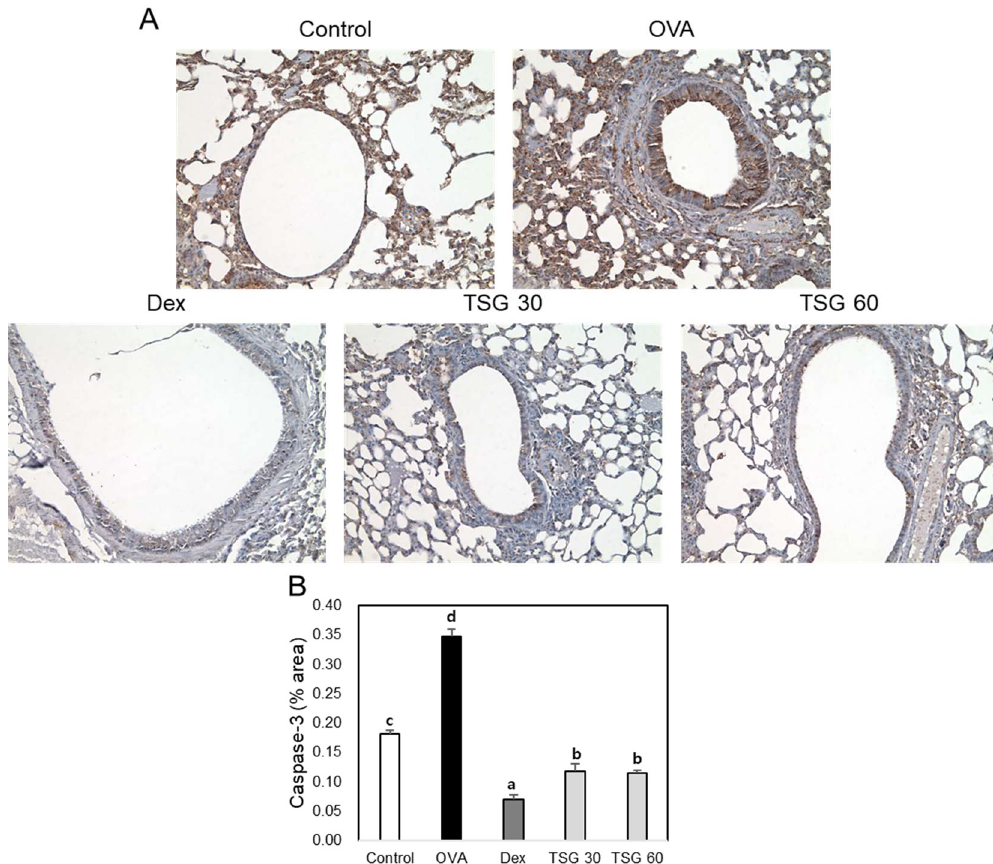
Figure 7. The effect of TSG on immunohistochemistry in the lung tissues of the OVA-induced murine model of asthma. C57BL/6 mice were sensitized and challenged with OVA for asthma induction. At the end of the experiment, the mice lungs were removed. ( A ) The lungs were stained by caspase-3 ( × 200) immunohistochemistry. The percentages of ( B ) caspase 3-positive cells in the lung sections were measured via Image J program. All data were expressed as means ± SD. a, b, c, and d: The means not sharing a common letter are significantly different between groups at p < 0.05 as measured by one-way ANOVA with Duncan’s multiple-range test.